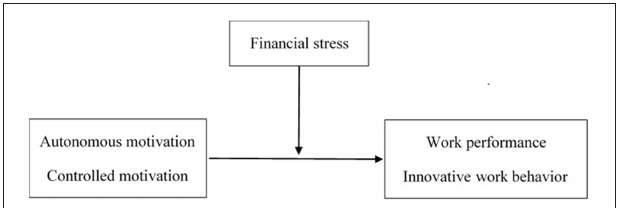
FIGURE 1 | Conceptual